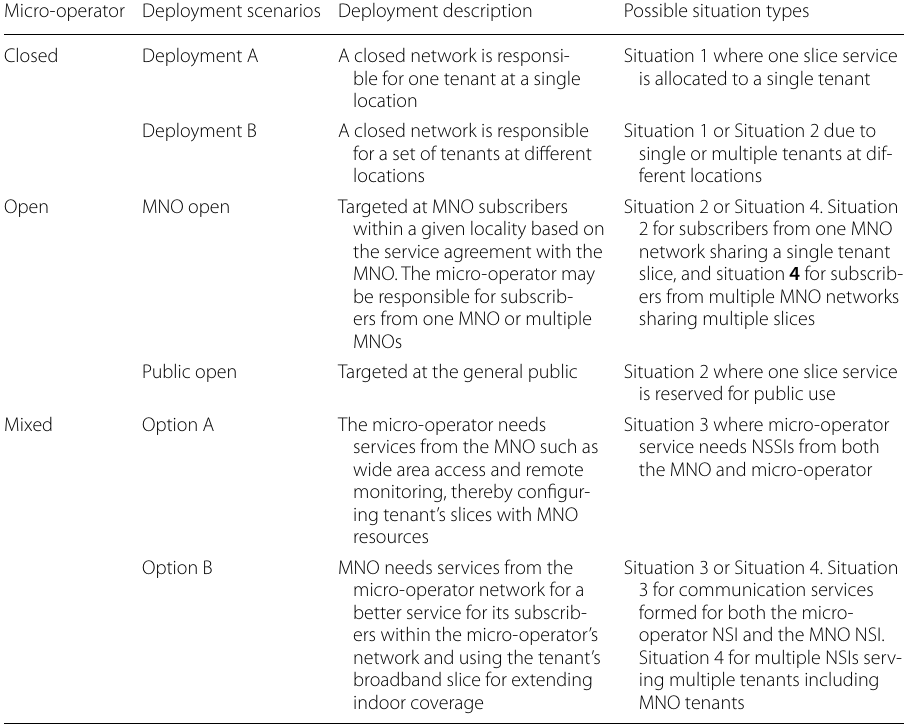
Table 1 Micro‑operator deployment scenarios mapped with situation types